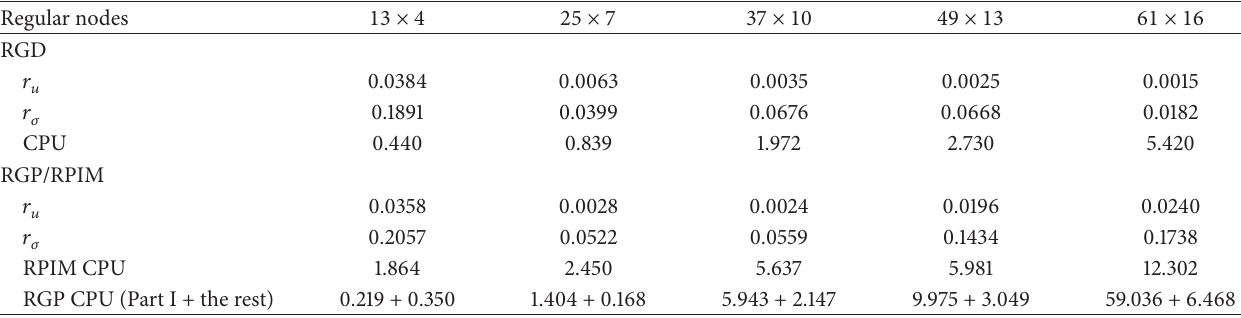
Table 4: Convergence study on regular nodes for Example 5.2 .